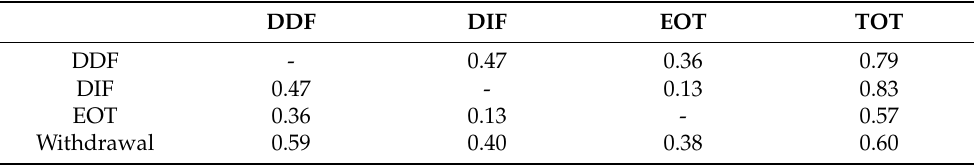
Table 3. Pearson’s r correlations between the TAS-20 values and the social withdrawal scale of the Youth Self-Report 11–18 (YSR), considering the sample as a whole.